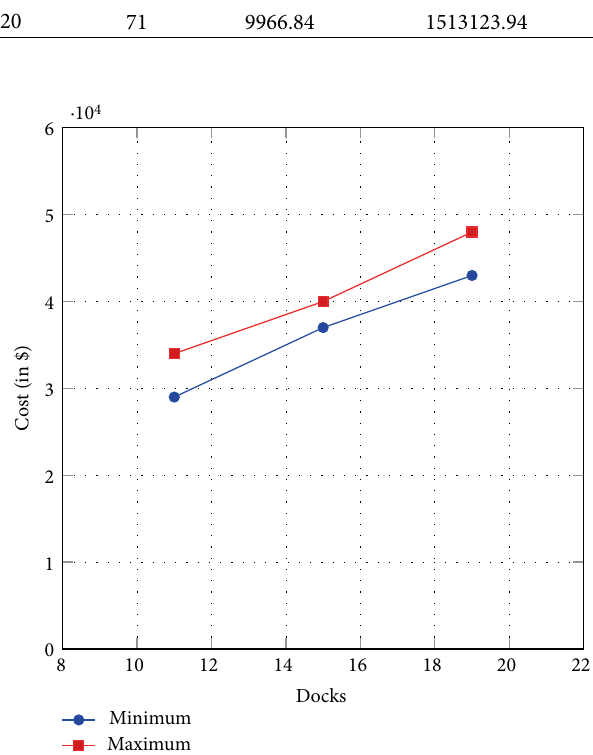
Figure 9: Equipment and installation cost vs. number of